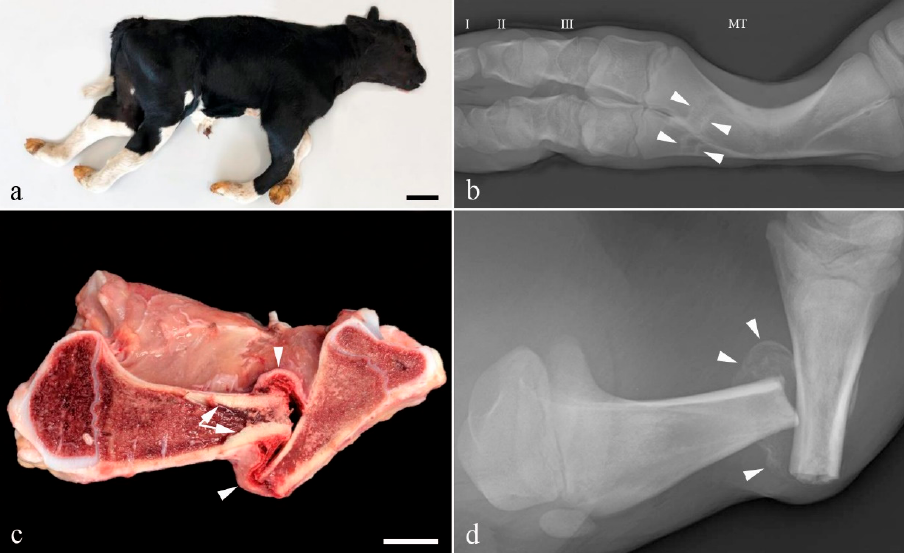
Figure 1. Gross morphology of the OI affected Holstein calf. ( a ) The limbs appear shortened and the distal joints are flexed. Bar = 10 cm; ( b ) Radiograph of a metatarsal bone (MT). The diaphysis is curved and transverse lines of sclerosis (arrow heads) are present distally. These may represent sites of healed fracture or growth arrest lines. Phalanx I, II and III are indicated by their respective numbers; ( c ) Longitudinal section through the left tibia. A transverse fracture with dislocation of the fracture ends is seen. Prominent osseous endostal proliferation has developed in the proximal part of the fracture (arrows). The fracture is surrounded by fibrosis (arrow heads). The width of the cortex is un-uniform with the caudal part of the proximal diaphysis/metaphysis being thin. Bar = 2.5 cm; ( d ) Radiograph of the specimen shown in ( c ) before longitudinal sectioning. The non-aligned fracture ends are surrounded by partly mineralized fibrous callus (arrow heads). Animals 2021 , 11 , 561